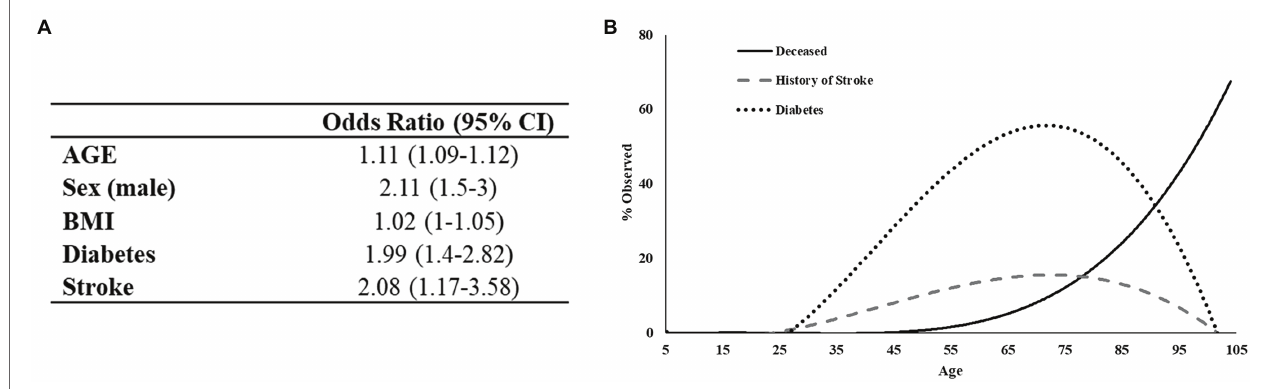
FIGURE 3 | Regression analysis of preexisting conditions associated with mortality in COVID-19 positive patients. (A) The deceased population shows an increased tendency toward diabetes and to a lesser extent history of stroke. (B) Logistic regression output. Test/Train model has 88% predictive